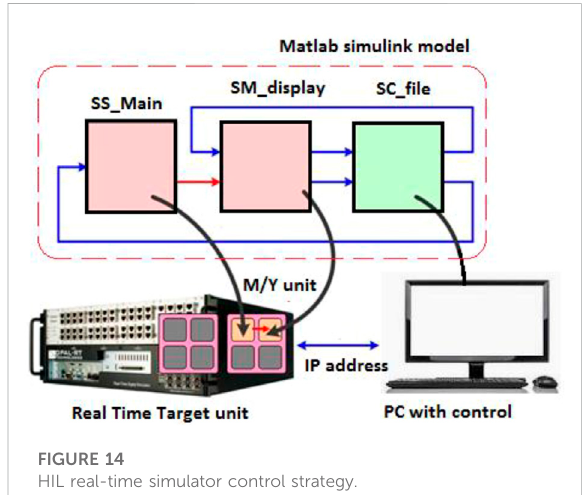
FIGURE 14 HIL real-time simulator control